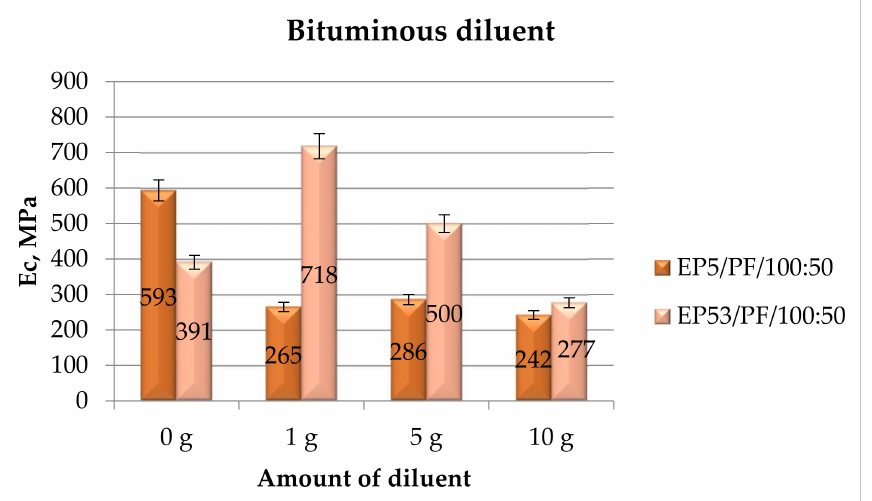
Figure 6. Compressive modulus calculated for Epidian 5 and Epidian 53 epoxy compounds as a function of the amount of bituminous